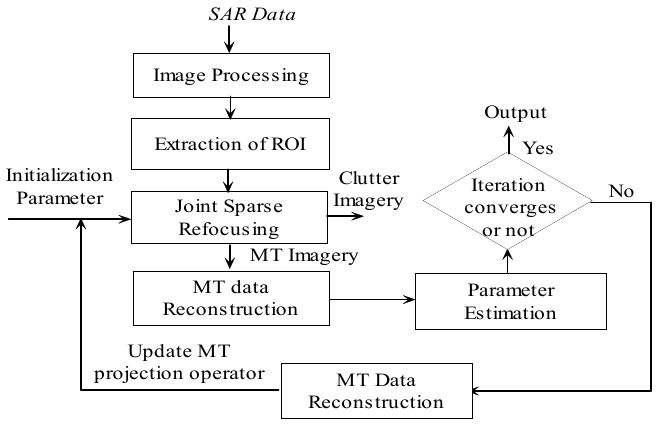
Figure 2. Joint sparse refocusing flow.